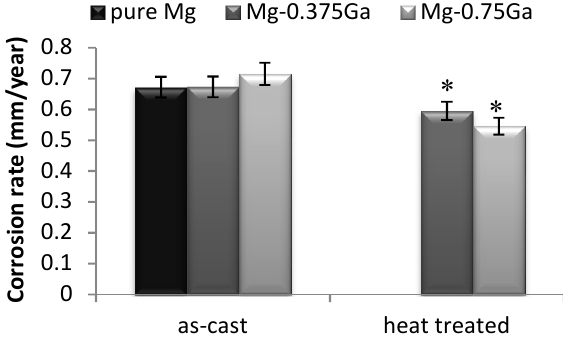
Figure 13. Corrosion rates before and after heat treatment for pure magnesium and Mg-Ga alloys after 504 h of immersion in SBF (*Statistically lower than 0.65 mm/year, p > 0.5).